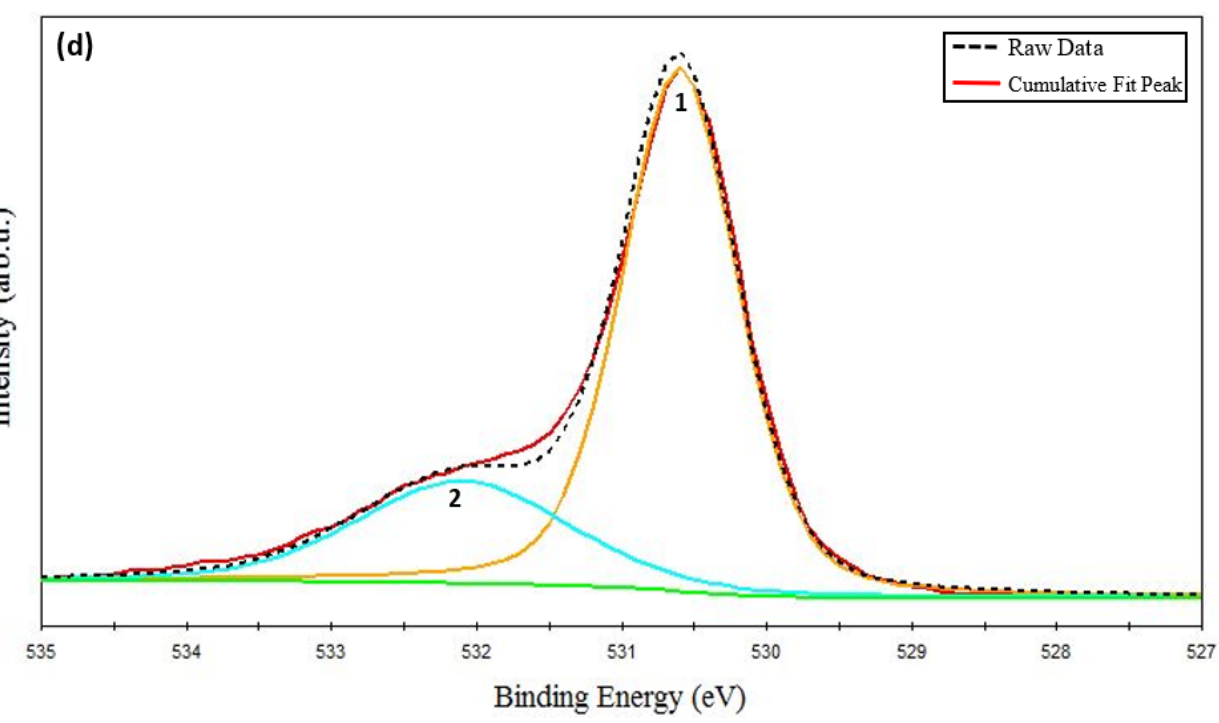
Figure 3. XPS spectra of CuCrO 2 film annealed at 650 °C: ( a ) survey spectrum, ( b ) Cu-2p, ( c ) Cr-2p, and ( d ) O-1s core level spectrum. Table 4. Full-width half maximum (FWHM), peak positions, satellite peak positions, and their respective binding energy of CuCrO 2 film annealed at 650 °C.